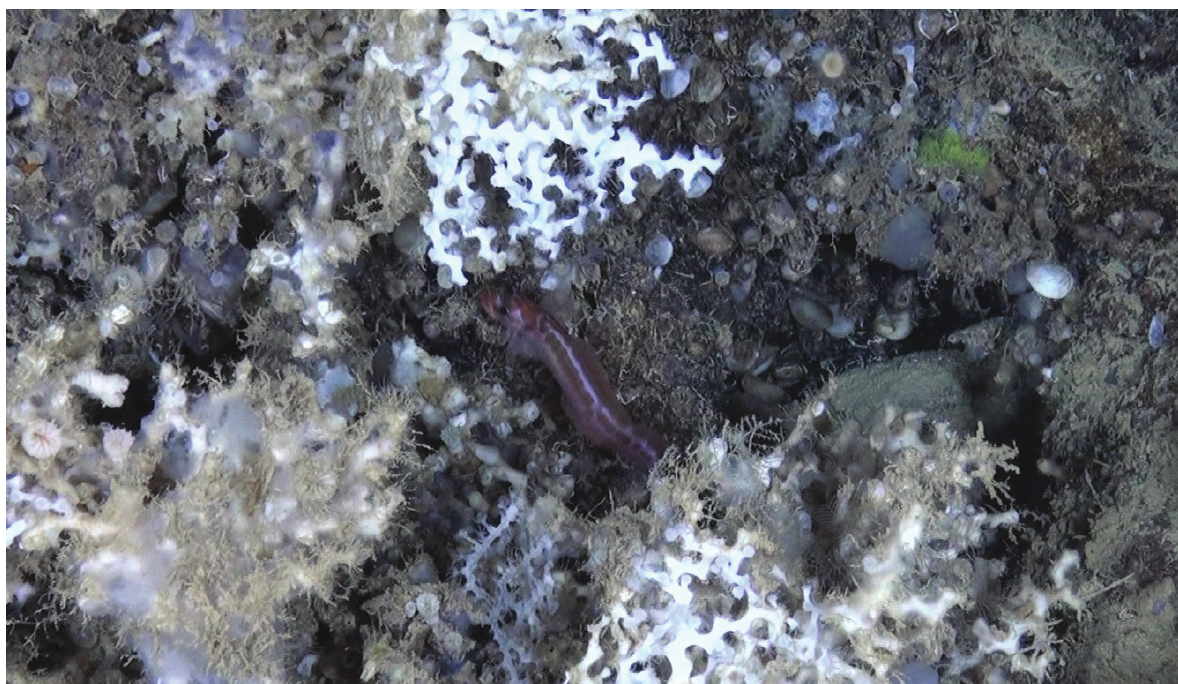
Figure 5. Image grab from ROV footage collected on 23 June 2015 at a depth of 871 m (35º52.880′N, 014º07.351′E) showing an individual of Gaidropsarus granti . Image: OCEANA © LIFE BaĦAR for